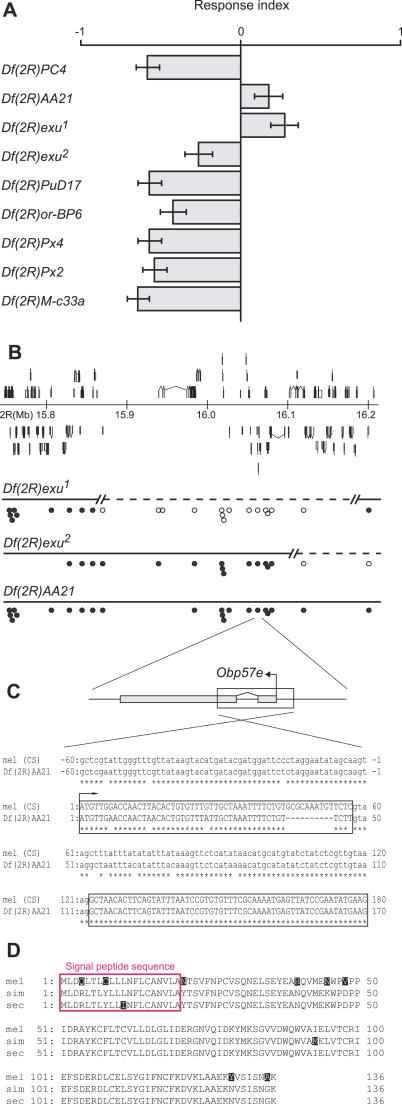
The Locus Responsible for Interspecies Difference in HA Avoidance Is Mapped to Obp57e
(A) Behavioral screening of interspecies hybrids between D. melanogaster deficiency strains and D. sechellia. Response to HA was measured by the trap assay [17]. Response index (RI) = (Nh − Nw)/(Nh + Nw), where Nh is the number of individuals trapped in 0.5% HA solution, and Nw is that of individuals trapped in distilled water. Error bars indicate 95% confidence intervals determined by the binominal test of summed data from five replications of the assay with 100 females for each replication.(B) Determination of break points in deficiency chromosomes. A filled circle indicates that the deficiency-chromosome–derived sequence was detected, and an open circle indicates that the deficiency-chromosome–derived sequence was not detected at that position.(C) The Df(2R)AA21 chromosome has a 10-bp deletion in the first exon of the Obp57e gene. A genomic sequence of Df(2R)AA21 is aligned with that of the wild-type strain (CS). Predicted ORFs are boxed and capitalized. Arrows indicate the position and direction of translation start sites (ATG).(D) Comparison of Obp57e structure between D. melanogaster (mel), D. simulans (sim), and D. sechellia (sec). Predicted signal peptide sequence is boxed. Altered amino acid residues are highlighted.